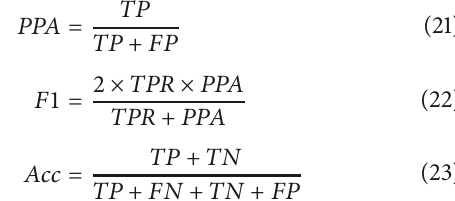
positive samples which are falsely classified into negative ones. Here, driving anger samples with certain intensity is supposed to be positive while the other driving anger samples are supposed to be